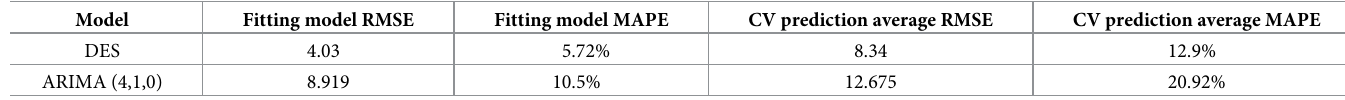
1. The modeling speed of the DES model is faster than that of the ARIMA model. Table 6. Characteristic evaluation of DES model and ARIMA